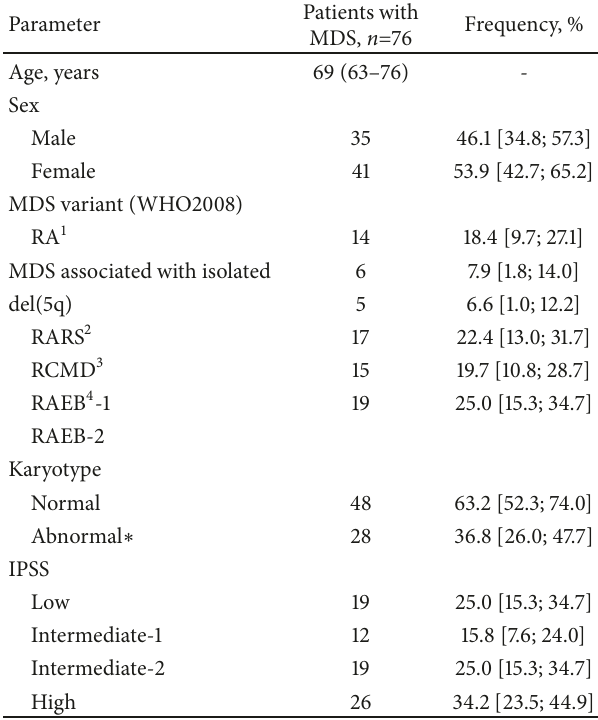
Table 2: The characteristics of patients with